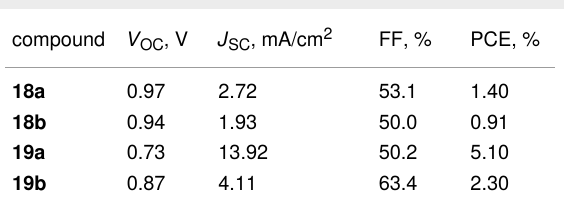
Table 3: Photovoltaic properties of OSCs based on polymers 18 and 19 with a monothienylisoindigo monomeric unit. compound V OC ,